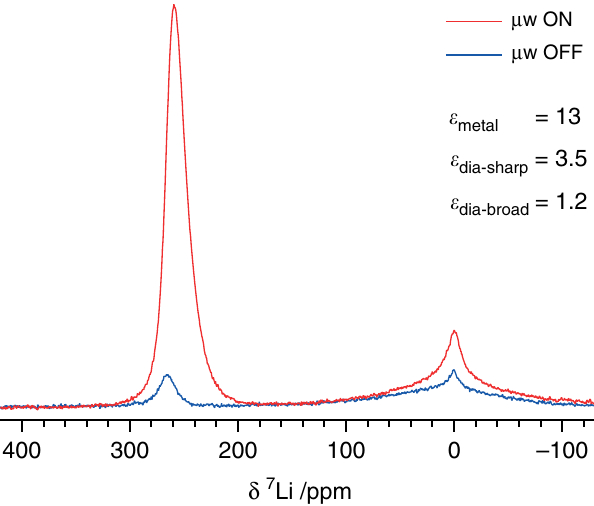
Fig. 4 Static DNP-enhanced NMR of microstructural lithium. 7 Li NMR spectra of sample C, recorded with and without microwave irradiation at 263.7 GHz and 44 W, at 9.4 T and room temperature, using a Hahn echo pulse sequence, a 0.25 s recycle delay and 128 scans. Shown too are the enhancements by area of the different